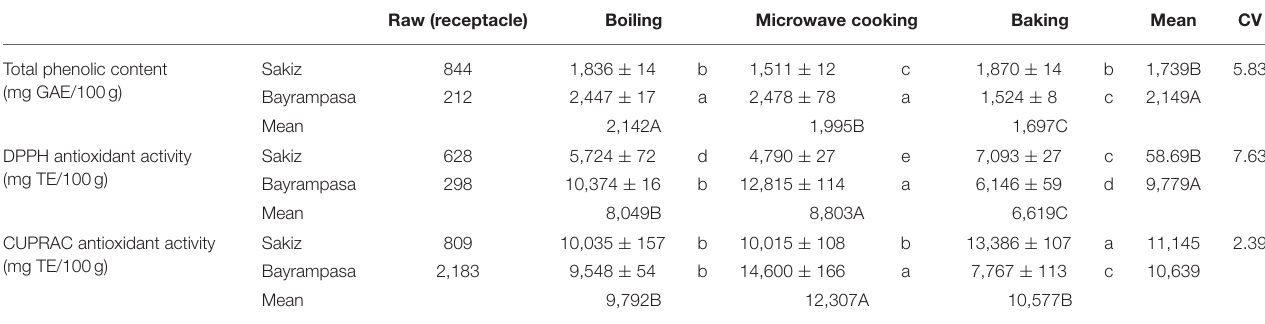
TABLE 3 | TPC, DPPH, and CUPRAC values of raw and cooked artichokes. Raw (receptacle) Boiling Microwave cooking